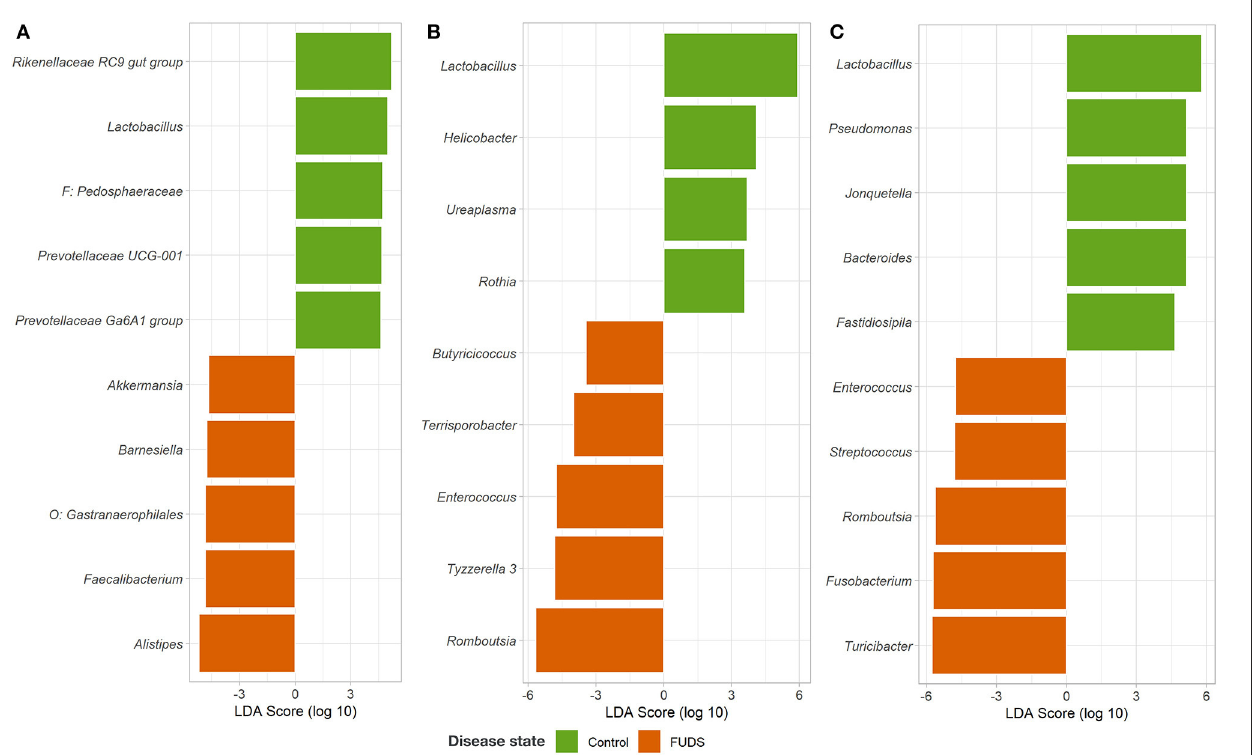
FIGURE6 Linear discriminant analysis (LDA) effect size (LEfSe) for microbial differential abundance between Control and FUDS affected flocks. (A) Cecum, (B) ileum, and (C)